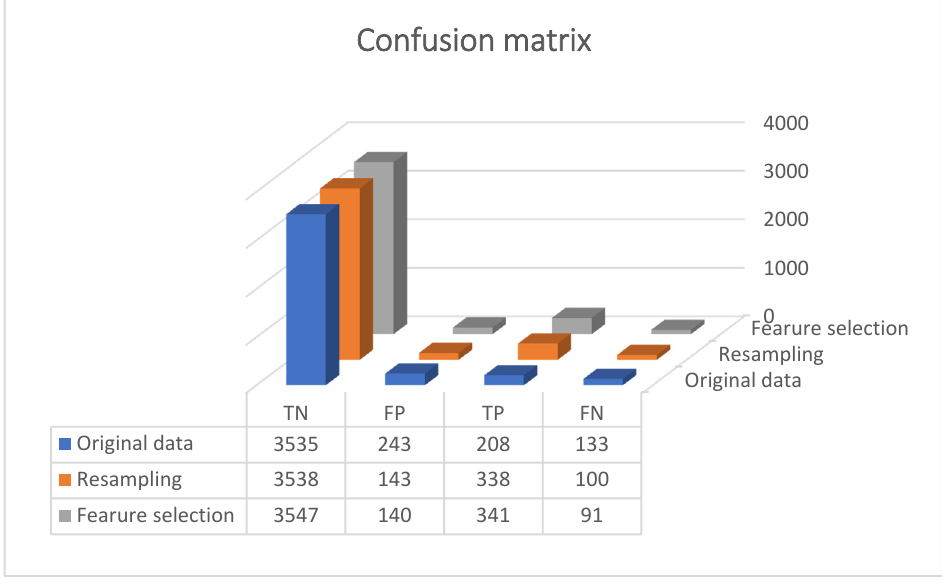
Figure 5. Compared models and methods after the last process.